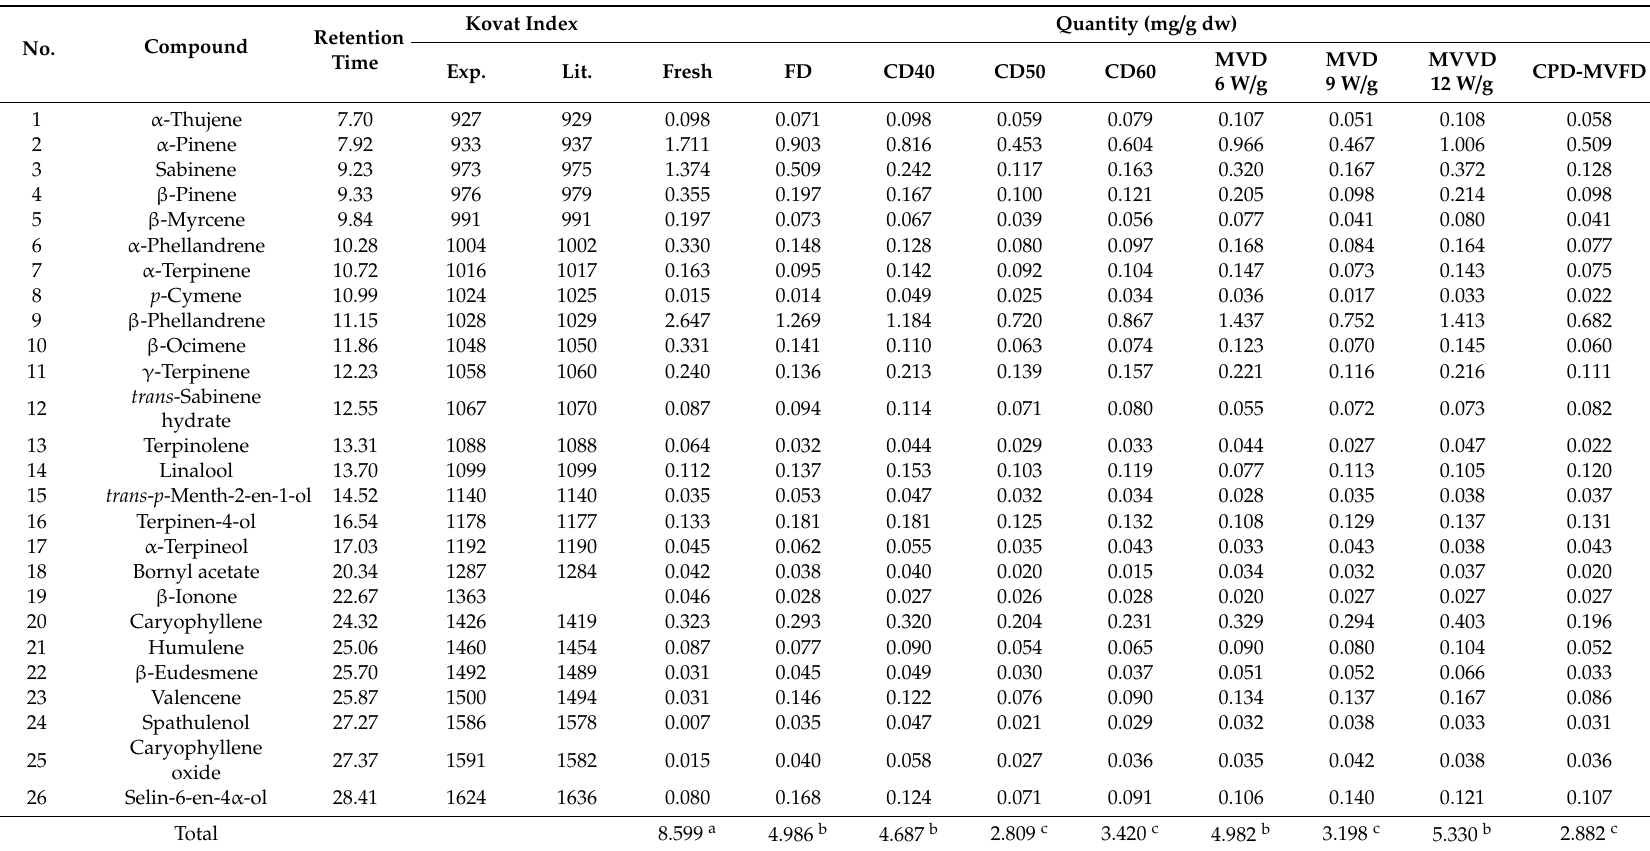
Table 3. Volatile compounds of dried M. koenigii leaves dried using di ff erent methods at di ff erent conditions and identified and quantified through GC-MS.